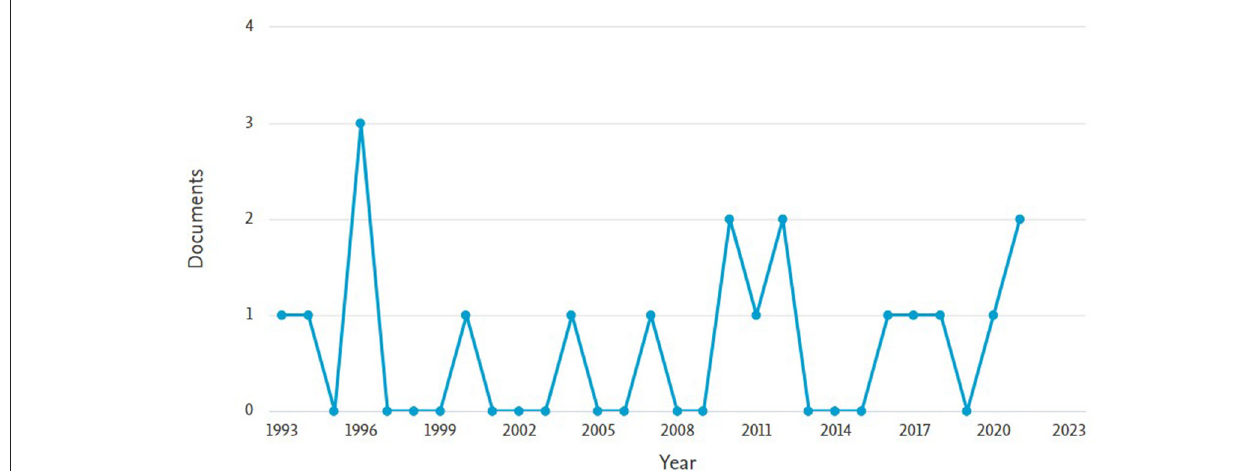
Frontiers in Psychology |